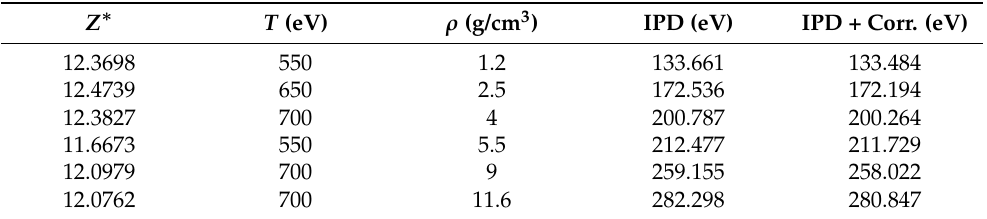
Table 3. Correction to the IPD due to Equation (18) for an Al plasma (conditions of Hoarty’s experiment [32]).